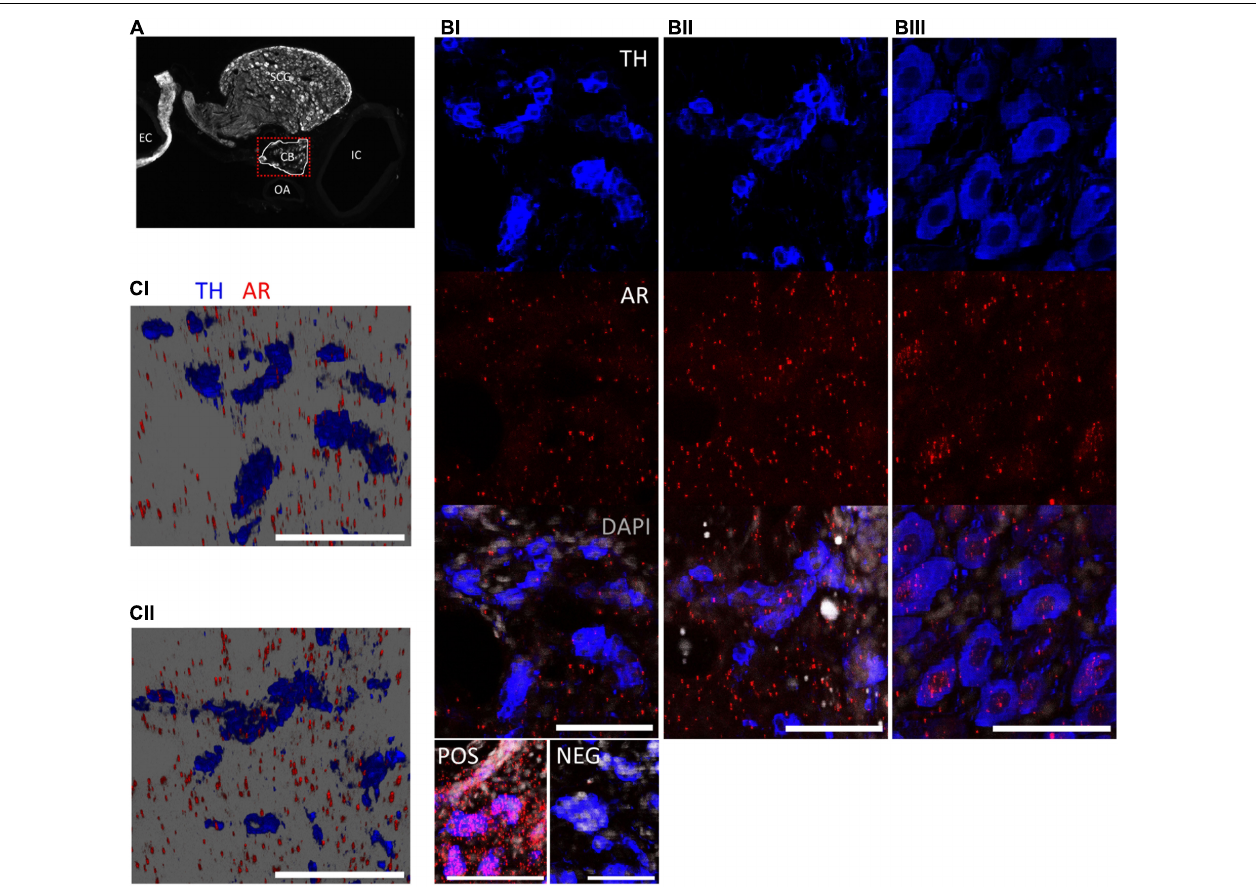
FIGURE 1 | Androgen receptor mRNA is present at low levels in the carotid bodies. (A) Image of the carotid bifurcation (25 µ m thick section) stained for tyrosine hydroxylase (TH); CB, carotid body; EC, external carotid artery; IC, internal carotid artery; OA, occipital artery; SCG, superior cervical ganglion. (BI,II) Representative confocal images of CBs show TH positive glomus cells (blue). Androgen receptor mRNA (AR, red) expression was weak in adult (i) and aging (ii) carotid tissue and rarely co-localized with glomus cells (images taken in ROI = red box). POS, NEG = positive and negative controls for RNAscope assay. (BIII) AR mRNA co-localized with TH-positive neurons of the SCG. (CI,II) 3D reconstruction of z-stacks from panels (BI,II) further suggest that while AR mRNA is expressed in the CB, it does not tend to occur in association with glomus cells of adult (i) or aging (ii) male rats. Scale bars = 50 µ